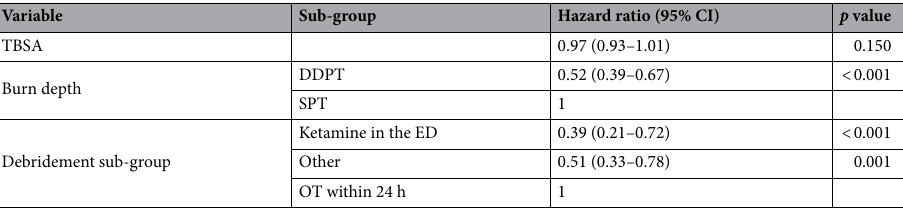
(Table 2). In comparison to children who received non-excisional wound debridement in the OT within 24-h post-burn, paediatric patients who underwent non-excisional debridement under Ketamine PSA in the ED had a 61% reduced chance of reaching 95% re-epithelialisation (Hazards Ratio = 0.39, 95% CI 0.21–0.72, p < 0.001). Furthermore, children debrided in ‘Other Settings’ had a 49% reduced chance of reaching 95% re-epithelialisation in comparison to children who received non-excisional debridement under general anaesthetic in theatre within